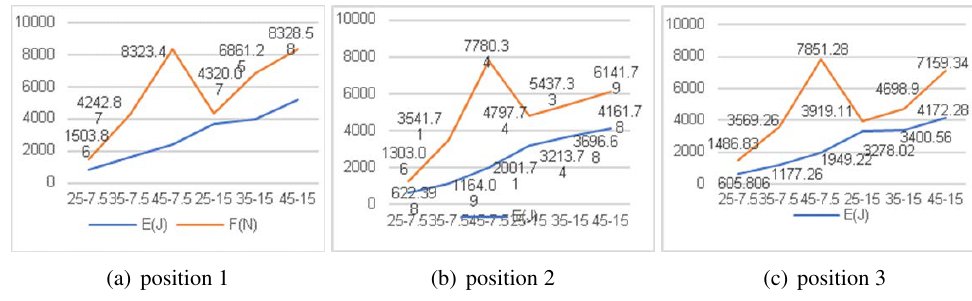
Fig. 4 Data from ‘large particles hitting small particles’